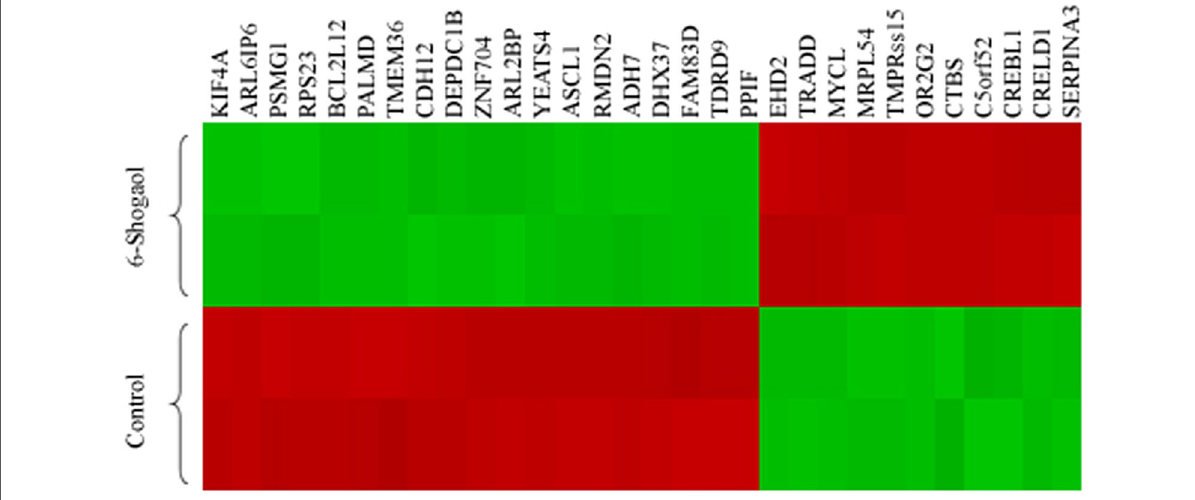
Fig. 1 The gene expression levels for the identified DEGs